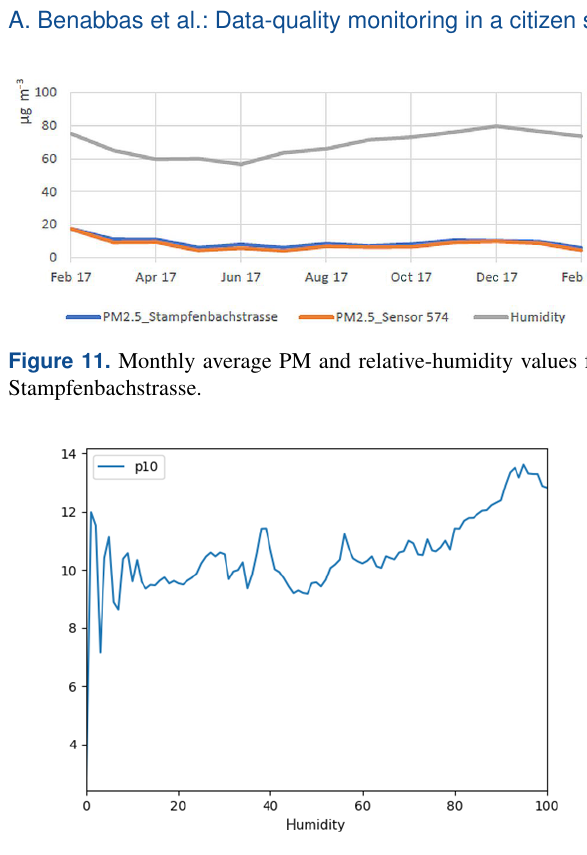
Figure 12. Median of PM 10 against relative air humidity over 1 year.